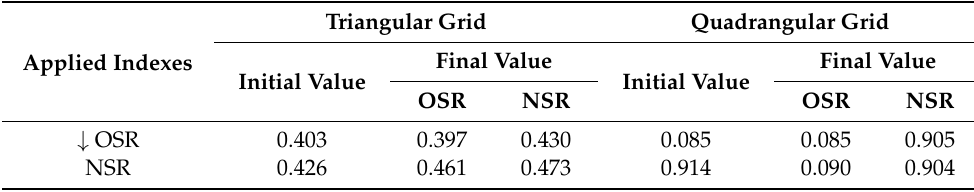
Table 2. The final results on comparing the shape